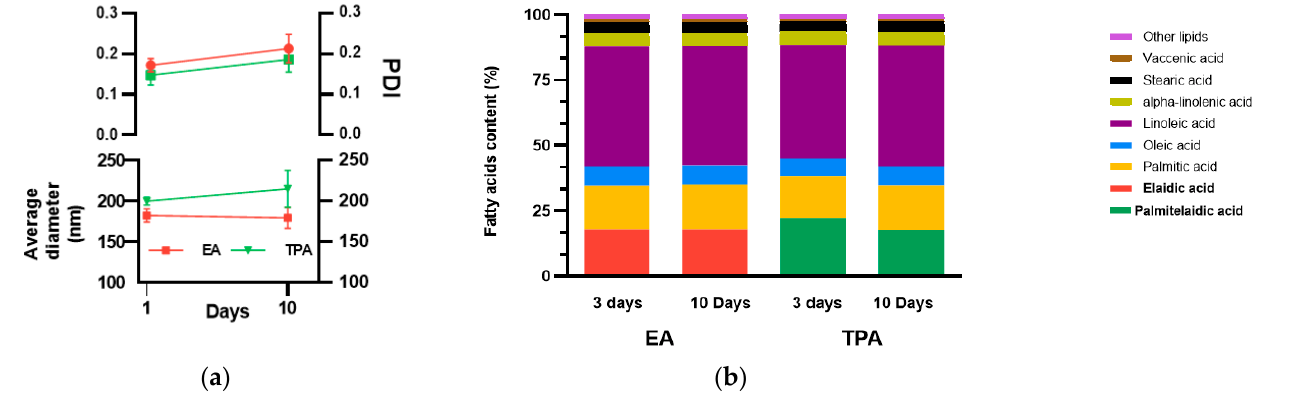
Figure 2. ( a ) Size distribution of vesicles. The vesicles are physically stable for periods up to 10 days; ( b ) composition of TFAs in nanovesicles. The vesicles were chemically stable for periods up to 10 days.